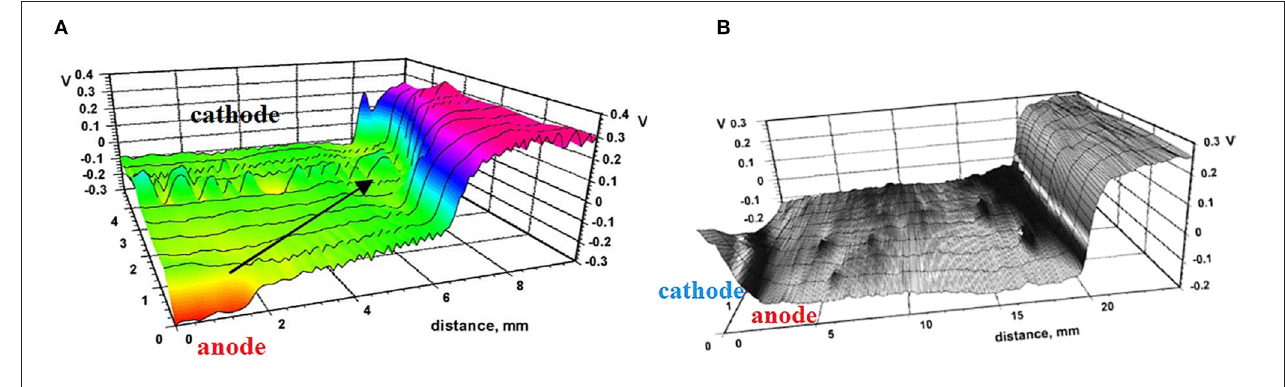
FIGURE 5 | SKP potential profile (potential in V vs. SHE) for a region of bare carbon steel surface that is locally contaminated by NaCl (left hand side), after 4h (A) and 100h (B) of exposure to air at 95% RH. An arrow marks the spreading of the area of cathodic reaction. Reprinted with permission from Elsevier (Nazarov and Thierry, 2004a).